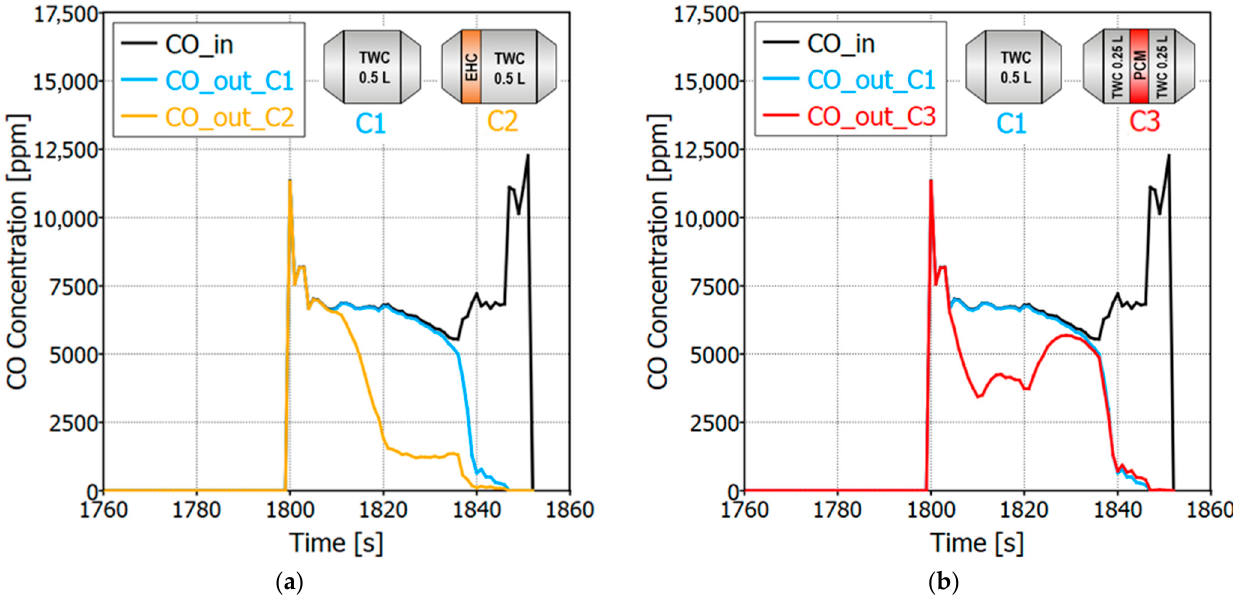
Figure 22. Predicted CO emissions after 30 min of soaking time ( a ) Effect of EHC (C2); ( b ) Effect of embedded PCM (C3).